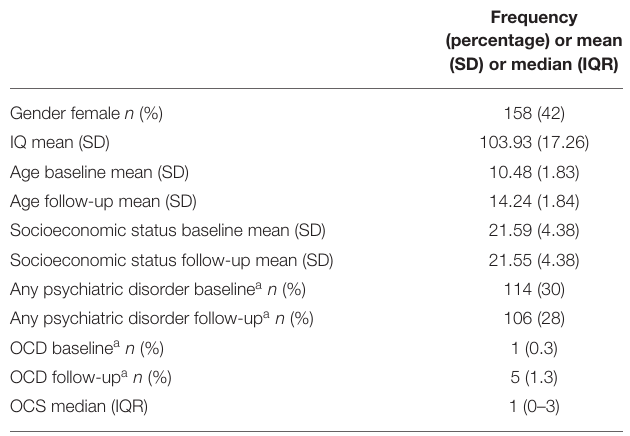
TABLE 1 | Demographic and clinical characteristics. TABLE 2 | Zero-altered negative binomial (ZANB) models examining the